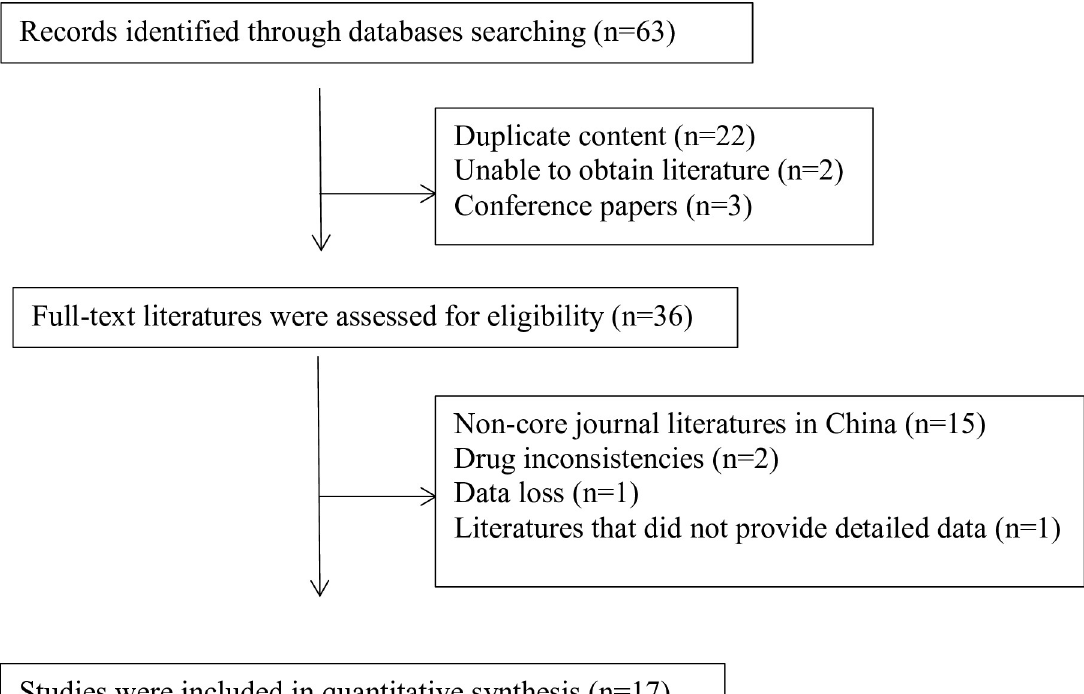
Fig 1. Summary of the process for identifying candidate